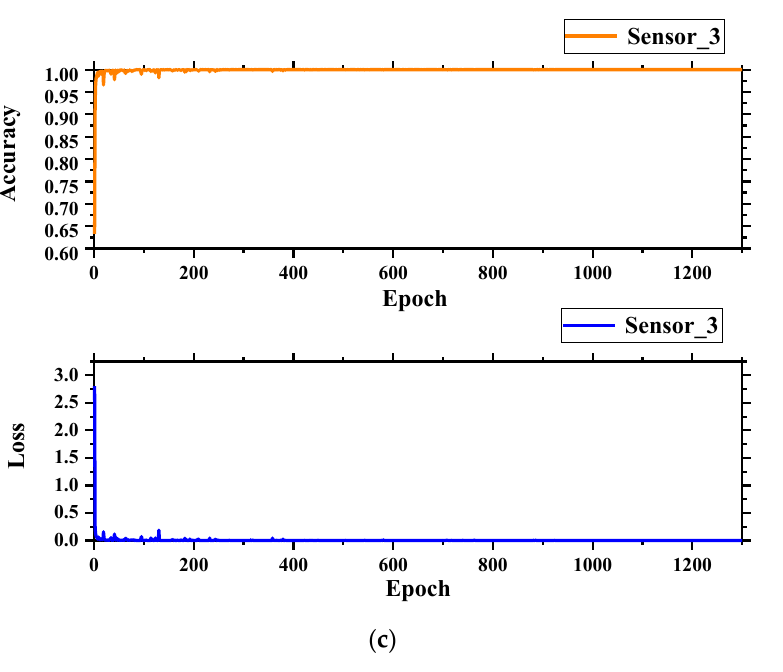
Figure 19. Multi-channel VGG16 model evaluation metrics. ( a ) sensor 1 under l = 10, ξ = 35 ◦ ; ( b ) sensor 2 under l = 6, ξ = 25 ◦ ; ( c ) sensor 3 under l = 6, ξ = 30 ◦ . According to Figure 19, sensor one had 99.92% accuracy and 0.0037 loss in the fault diagnosis model of VGG16; sensor two had 99.96% accuracy and 0.0021 loss; sensor three had 99.91% accuracy and 0.00475